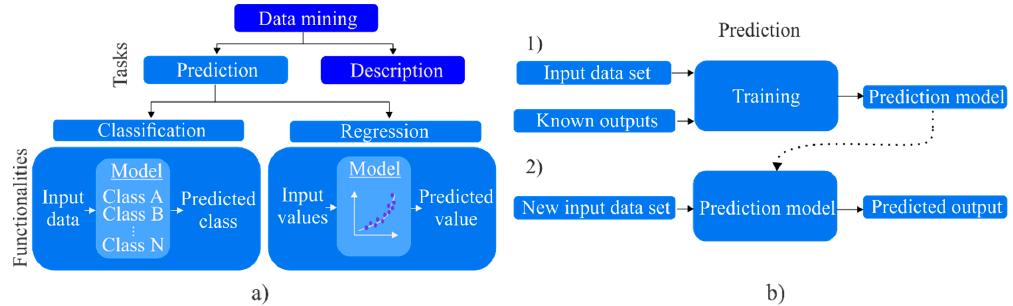
Figure 2. (a ) Schematic diagram for tasks and functionalities of data mining (DM) and ( b ) prediction model.